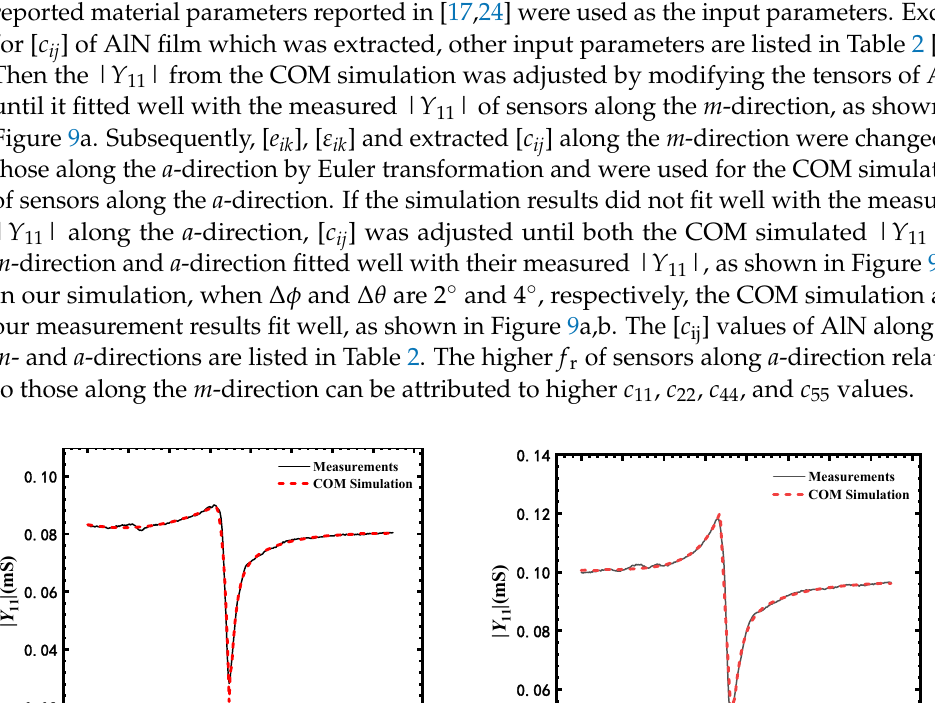
COM theory. COM theory.